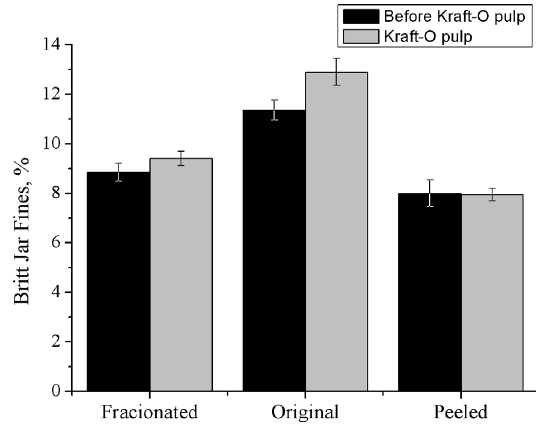
Figure 4. Britt Jar fines content in the original, treated and delignified with oxygen pulps.